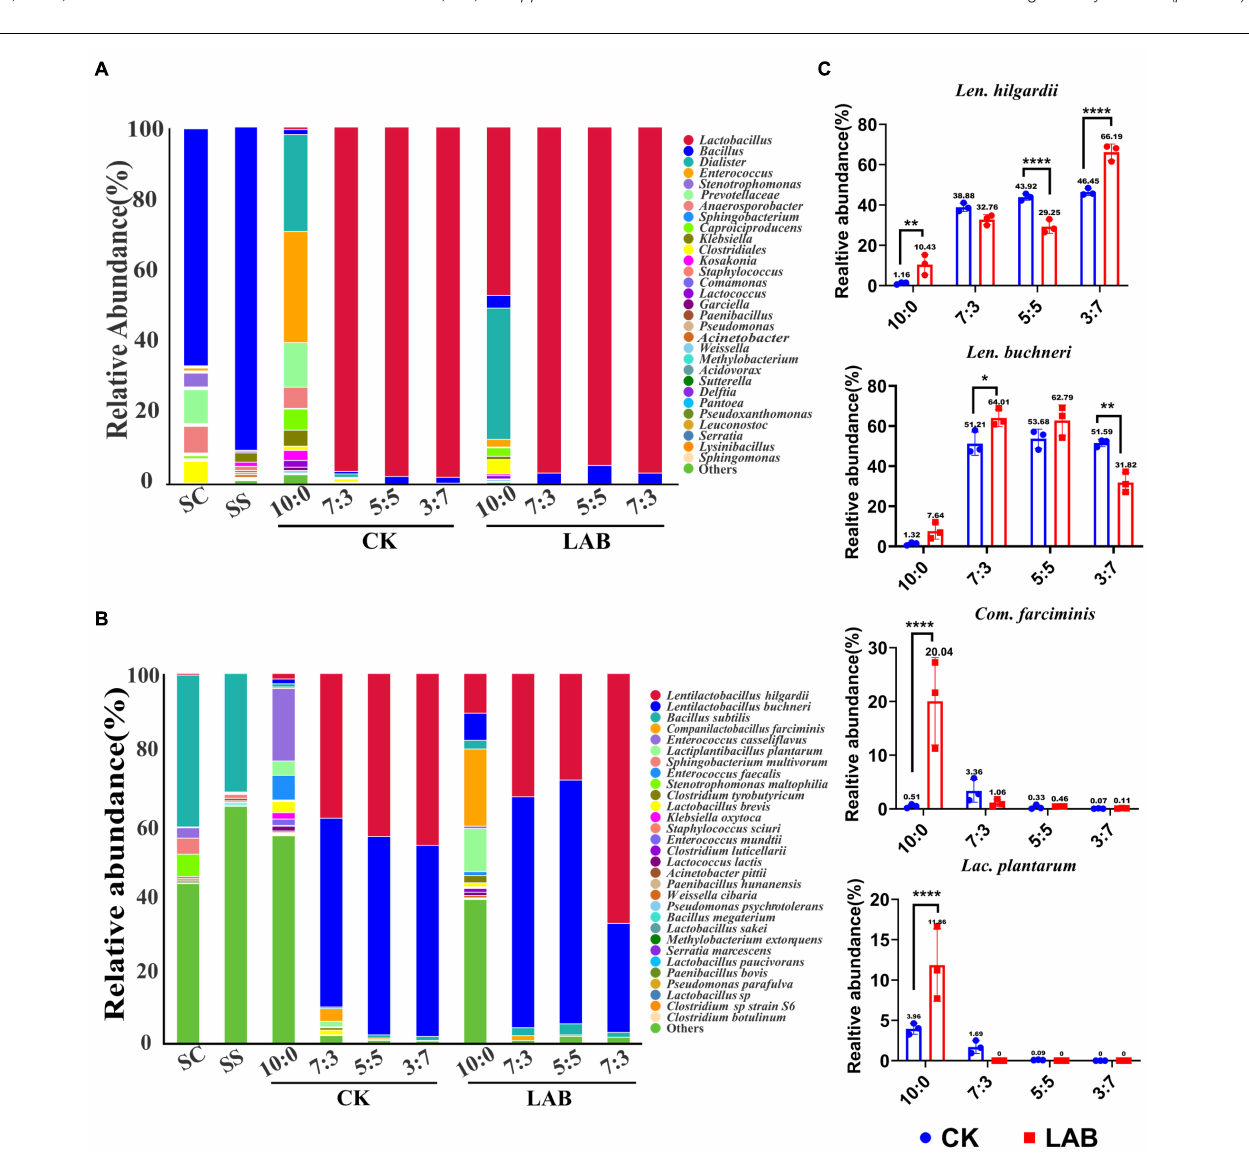
FIGURE 2 | The bacterial community of SC-SS silage. (A) Bacterial composition at the genus level. (B) Bacterial composition at the species level. CK, untreated group; LAB, lactic acid bacteria inoculation group. (C) Relative abundance of Com. farciminis , Lac. plantarum , Len. buchneri , Len. hilgardii in the SC-SS silage, respectively. * p < 0.05; ** p < 0.01; **** p < 0.0001.